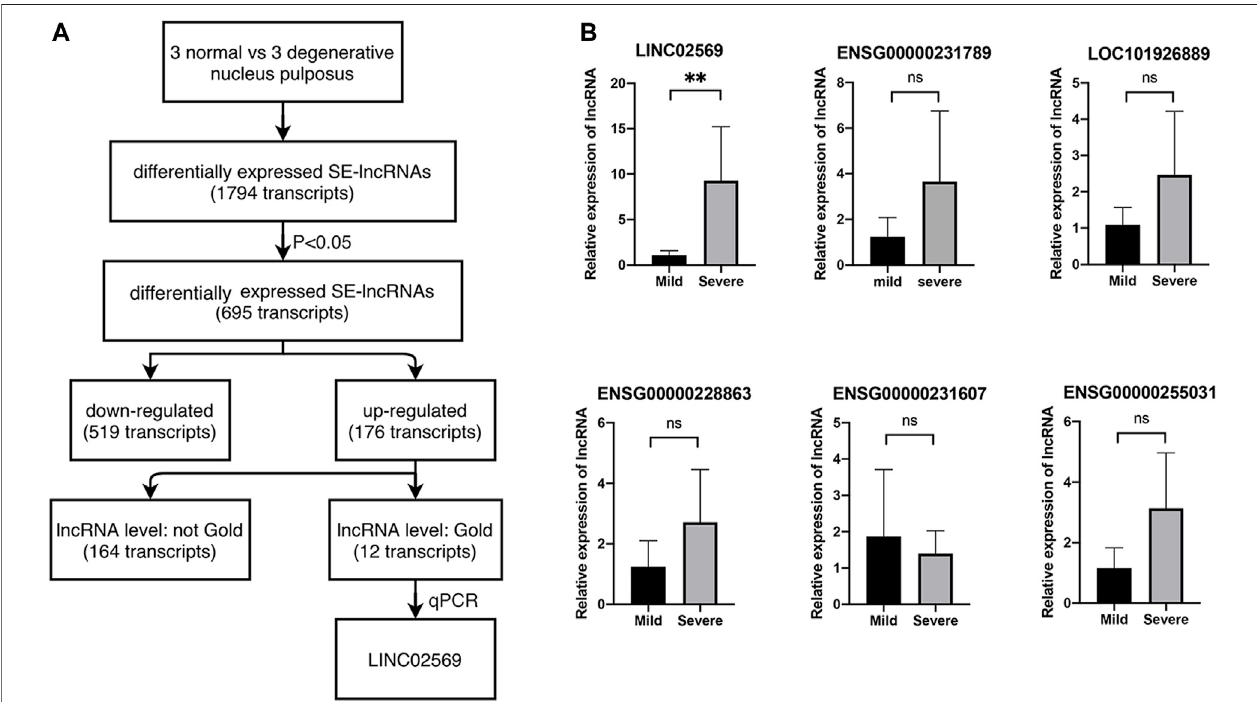
FIGURE 1 | Identi fi cation of lncRNAs. (A) Selection strategy of lncRNAs from a genome-wide pro fi ling between normal and degenerative NPs. (B) Expression of LINC02569 and other 5 lncRNAs measured by qRT-PCR in severe degenerative NPCs as compared to mild degenerative ones. Quantitative results are shown as the mean ± SD. pp p < 0.01. ns, not statistically signi fi